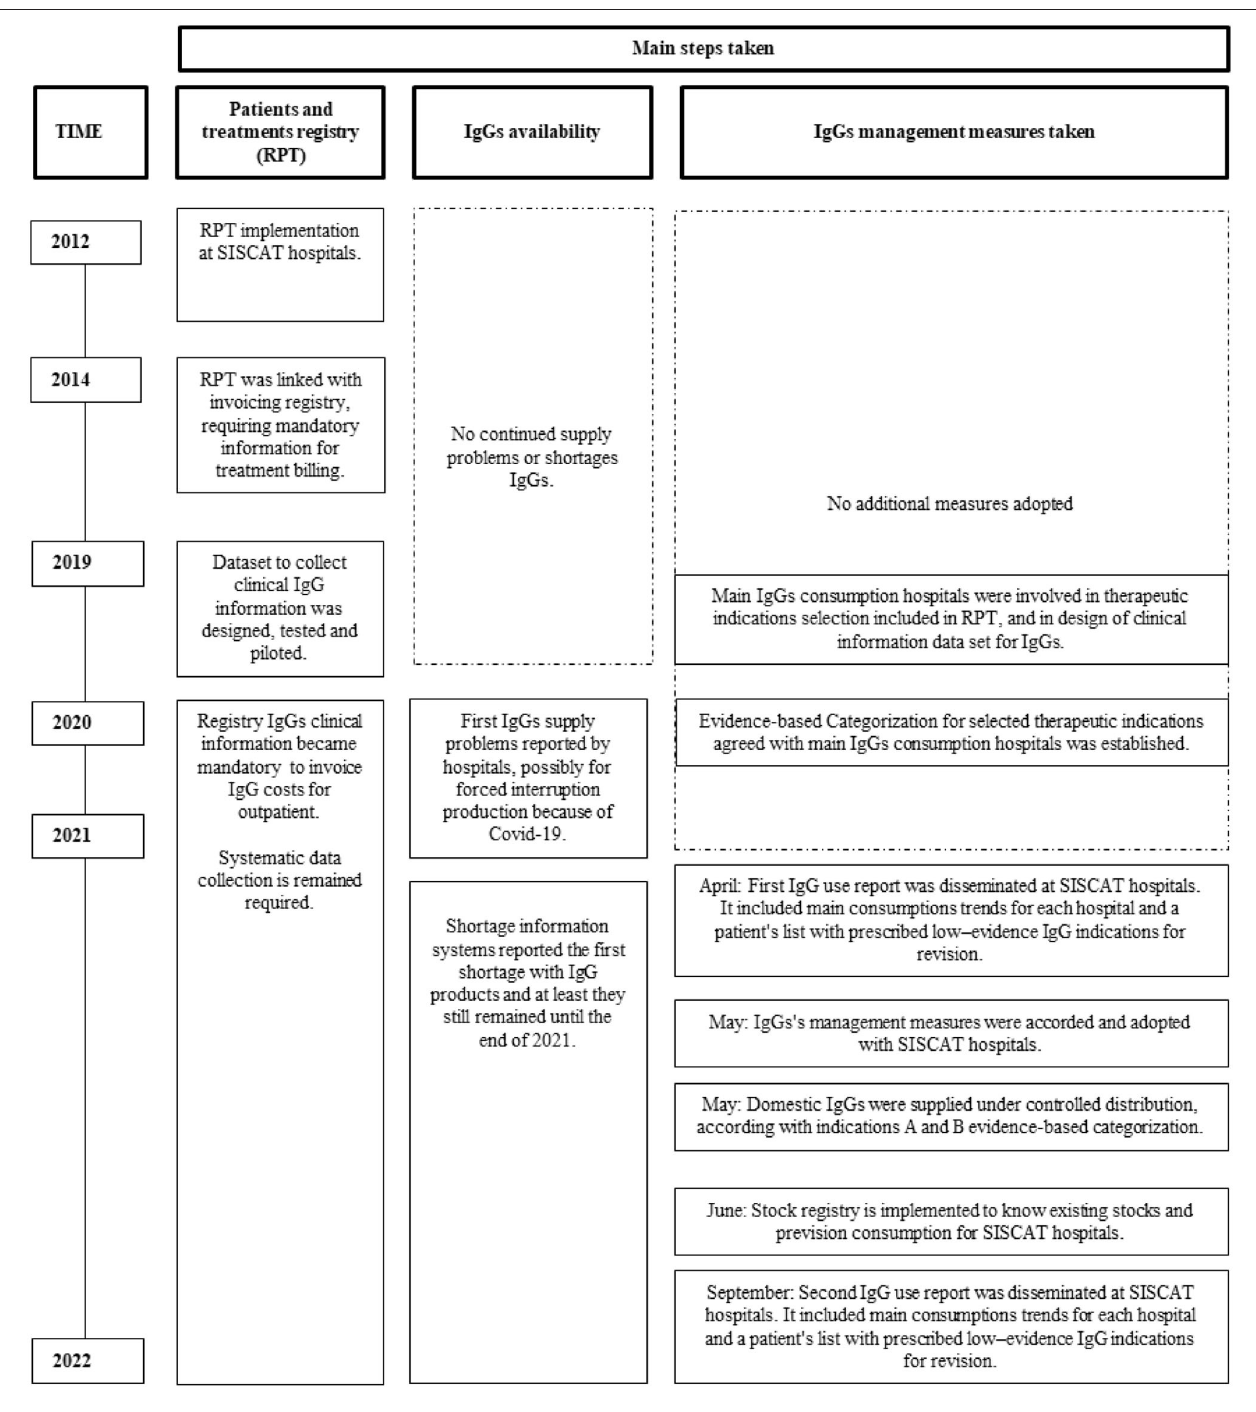
FIGURE 1 | Main steps taken with patients and treatments registry, immunoglobulin (IgG) availability and IgG management measures taken trough time.